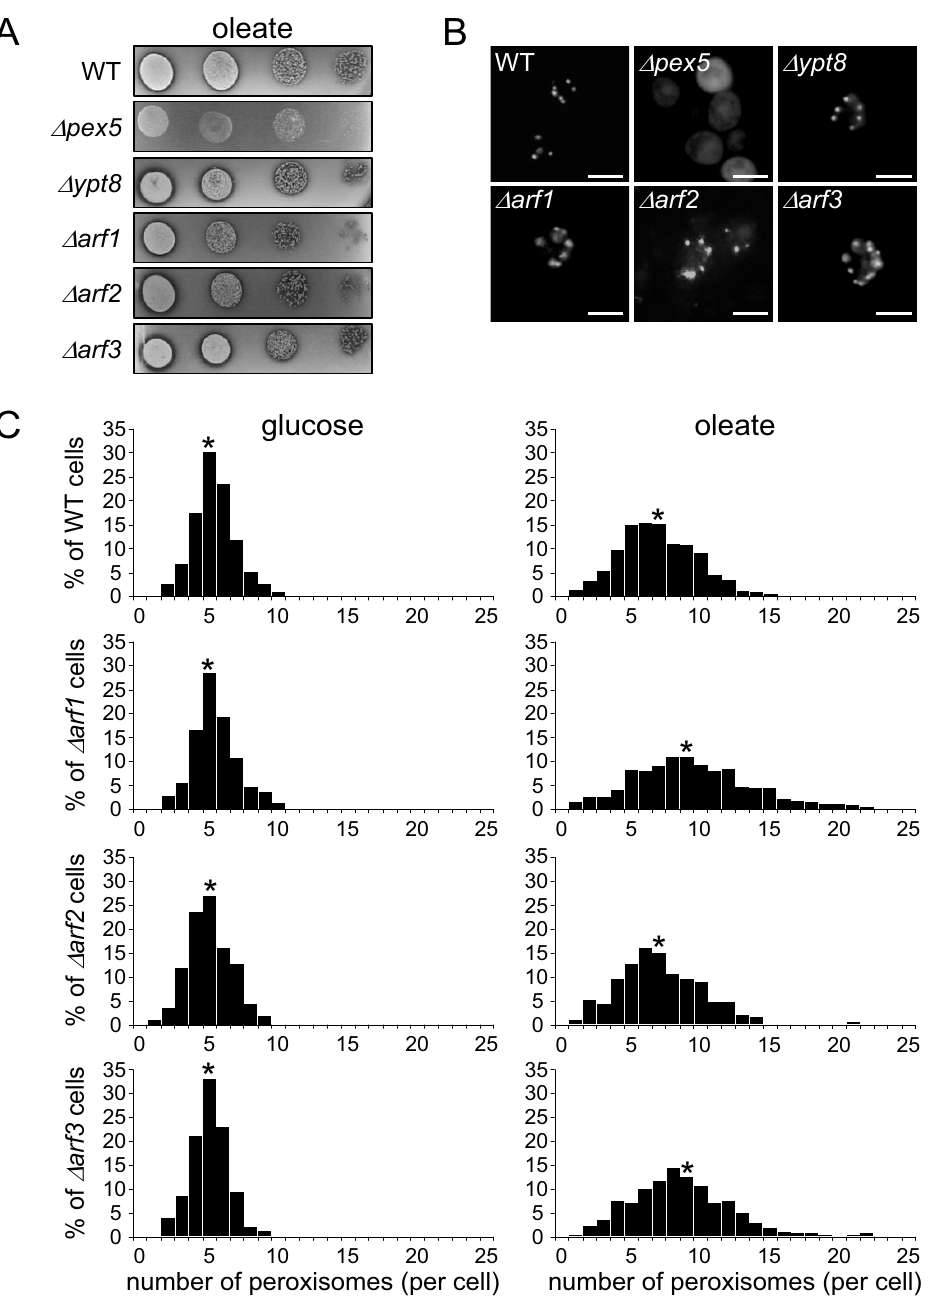
Figure 1 Phenotypic analysis of various S. cerevisiae (deletion) strains . Serial dilutions of wild-type (WT) yeast cells (strain BY4741) and yeast cells deficient in Pex5p ( Δ pex5 ), Ypt8 ( Δ ypt8 ), Arf1 ( Δ arf1 ), Arf2 ( Δ arf2 ), or Arf3 ( Δ arf3 ) expressing EGFP- PTS1 were spotted onto plates with oleate as a sole carbon source. (A) The plates were subsequently incubated at 30°C for seven days, and oleate consumption was scored by halo formation. (B) Two days later, the subcellular distribution pattern of EGFP-PTS1 was visualized by fluorescence microscopy. The scale bar represents 5 μ m. (C) The number of peroxisomes per cell was counted in randomly selected cells. The mean number of peroxisomes per cell is indicated by an asterisk. At least 100 glucose-grown and 400 oleate-grown cells were